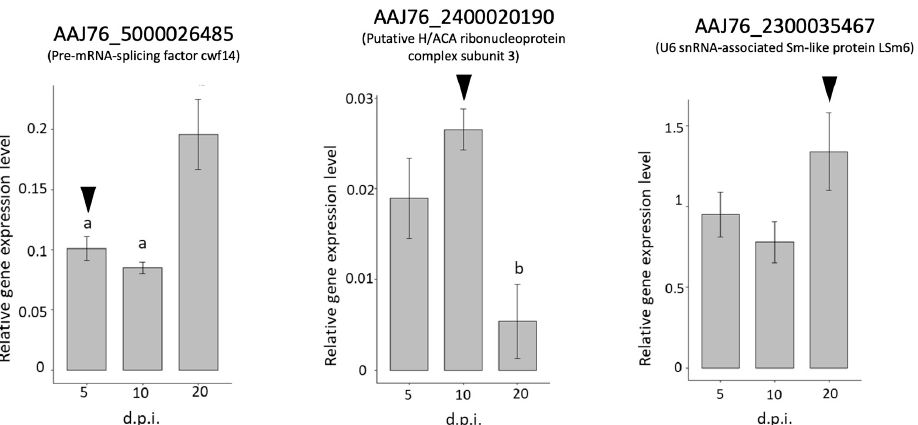
Figure 7. Validation of N. ceranae gene expression in upregulated stage-specific genes during N. ceranae infection. The bar plots show the relative gene expression levels of different stage-specific genes at different d.p.i. The black arrowheads indicate the time point at which the highest expression level of the gene was predicted based on RNA-seq data. Different letters indicate significant differences ( p <